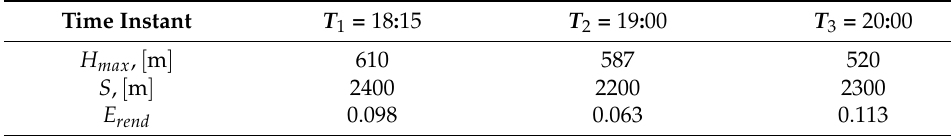
Figure 9. Dynamic soaring cycles. ( a ) sailplane trajectories for three Mars times; ( b ) a single cycle with positive dE / dt markers; ( c ) energy time history for each cycle. Table 3. Characteristics of dynamic soaring